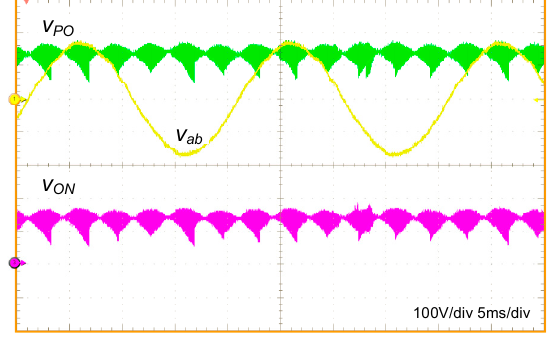
Figure 17. Experimental results of DC-link voltage.